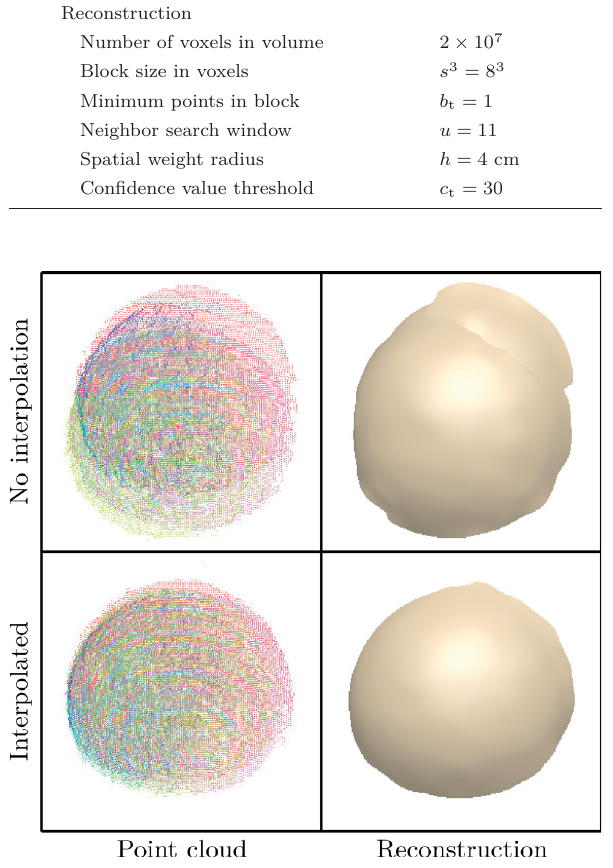
Fig. 8 Frame interpolation using a fast-moving spherical object. Without interpolation (above), the point clouds from the different cameras are not aligned. Using interpolation (below), the point clouds are aligned and the object is correctly